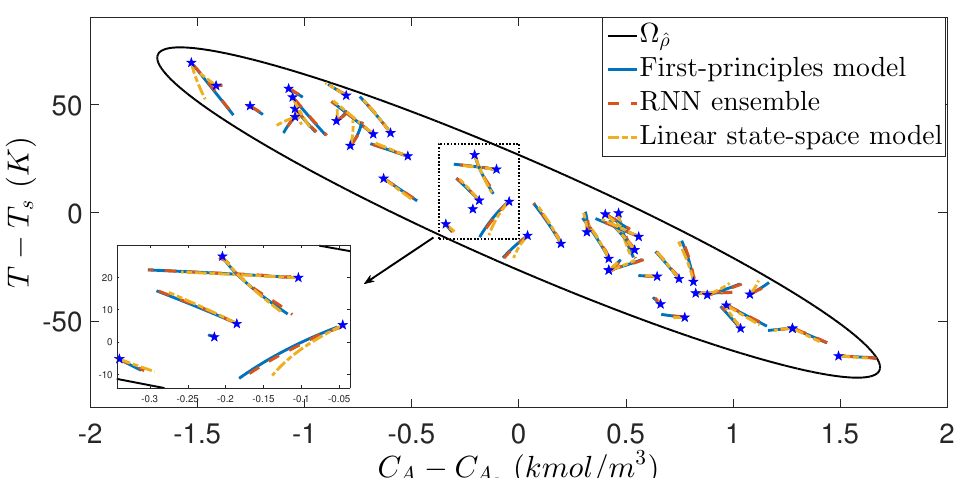
Figure 5. The state trajectories for the open-loop simulation using the first-principles model of Equation (33), the ensemble of RNN models, and the linear state-space model, respectively for various sets of inputs and initial conditions (marked as blue stars) x 0 in the closed-loop stability region Ω ˆ ρ